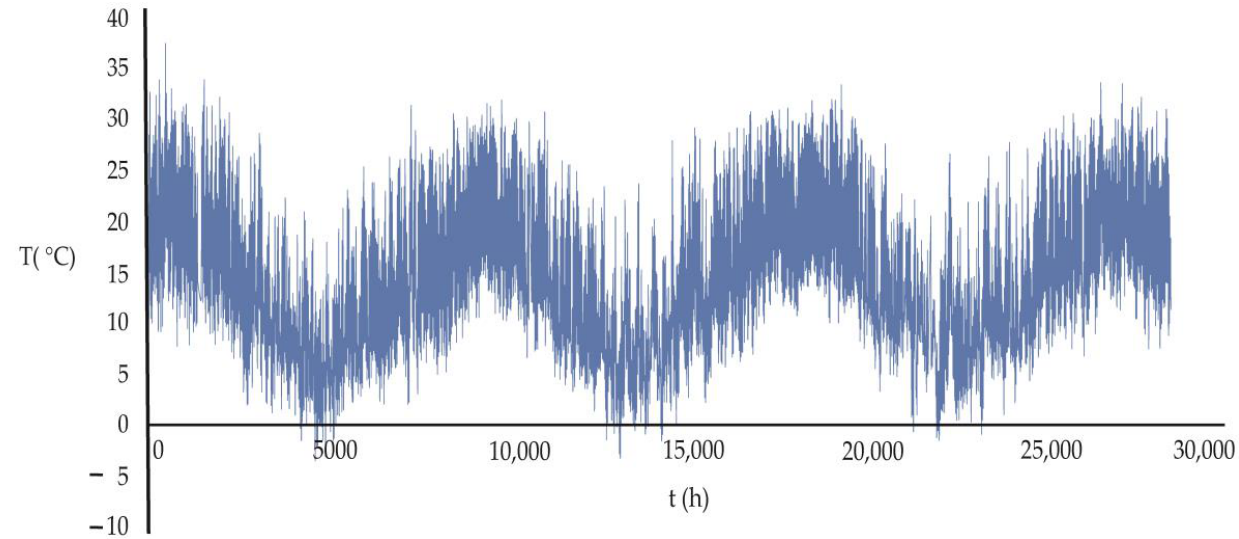
Figure 2. Distribution of the 28,463 hourly temperatures of the period 2010 – 2013 for the Puente Alto commune. The data distribution of the magnitude of the wind speed over time, for the other five communes, is similar to that shown in the figure.